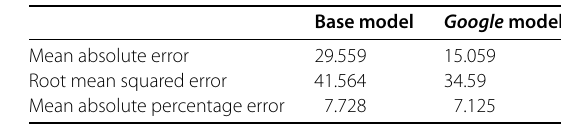
Table 7 Nowcasting performance